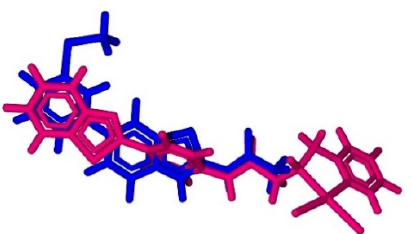
Figure 3. Complex 1 (pink) docked in the active site of PI3K. The active ligand is shown in blue.